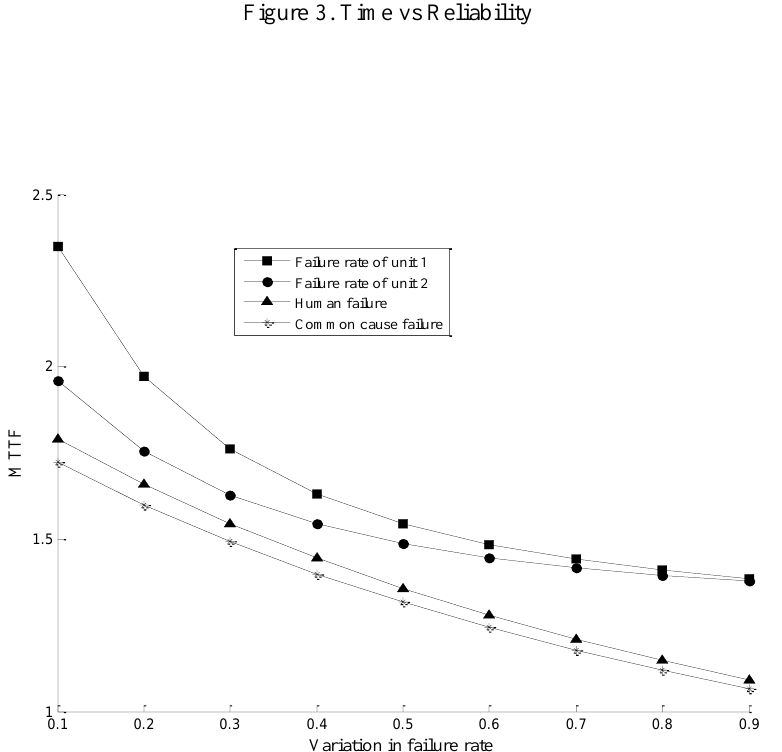
Figure 3. Time vs Reliability